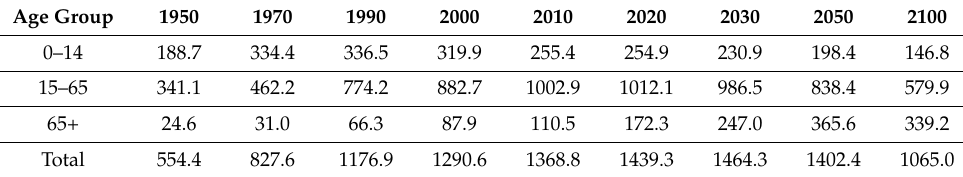
Table 2. Development of the Chinese population (million inhabitants—middle variant).